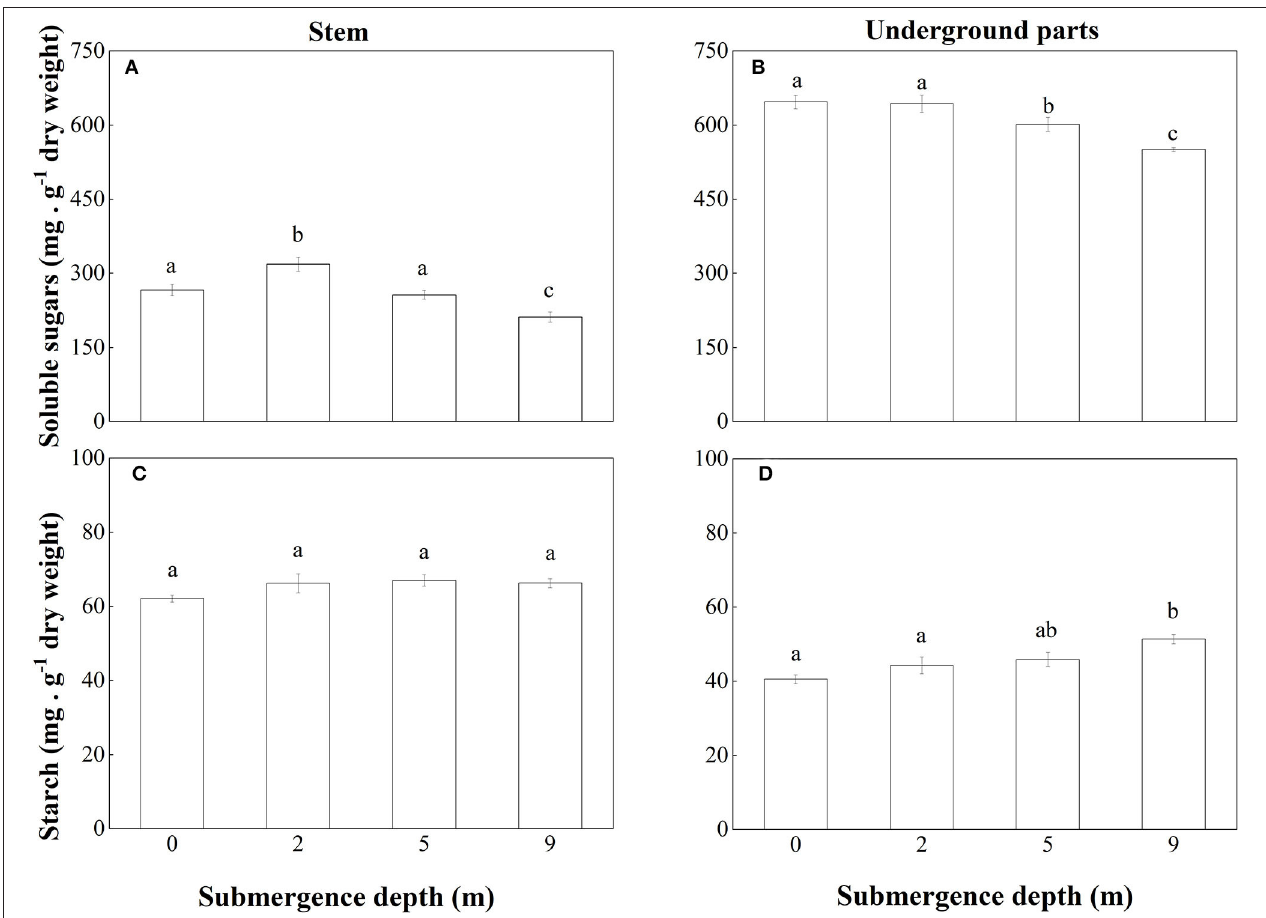
FIGURE 6 | Concentrations of soluble sugars in (A) stems and (B) underground parts; starch in (C) stems and (D) underground parts of A. philoxeroides at the end of the submergence treatments (Mean ± S.E; n = 5). Different lower-case letters indicate significant differences ( p < 0.05 using one-way ANOVA) between